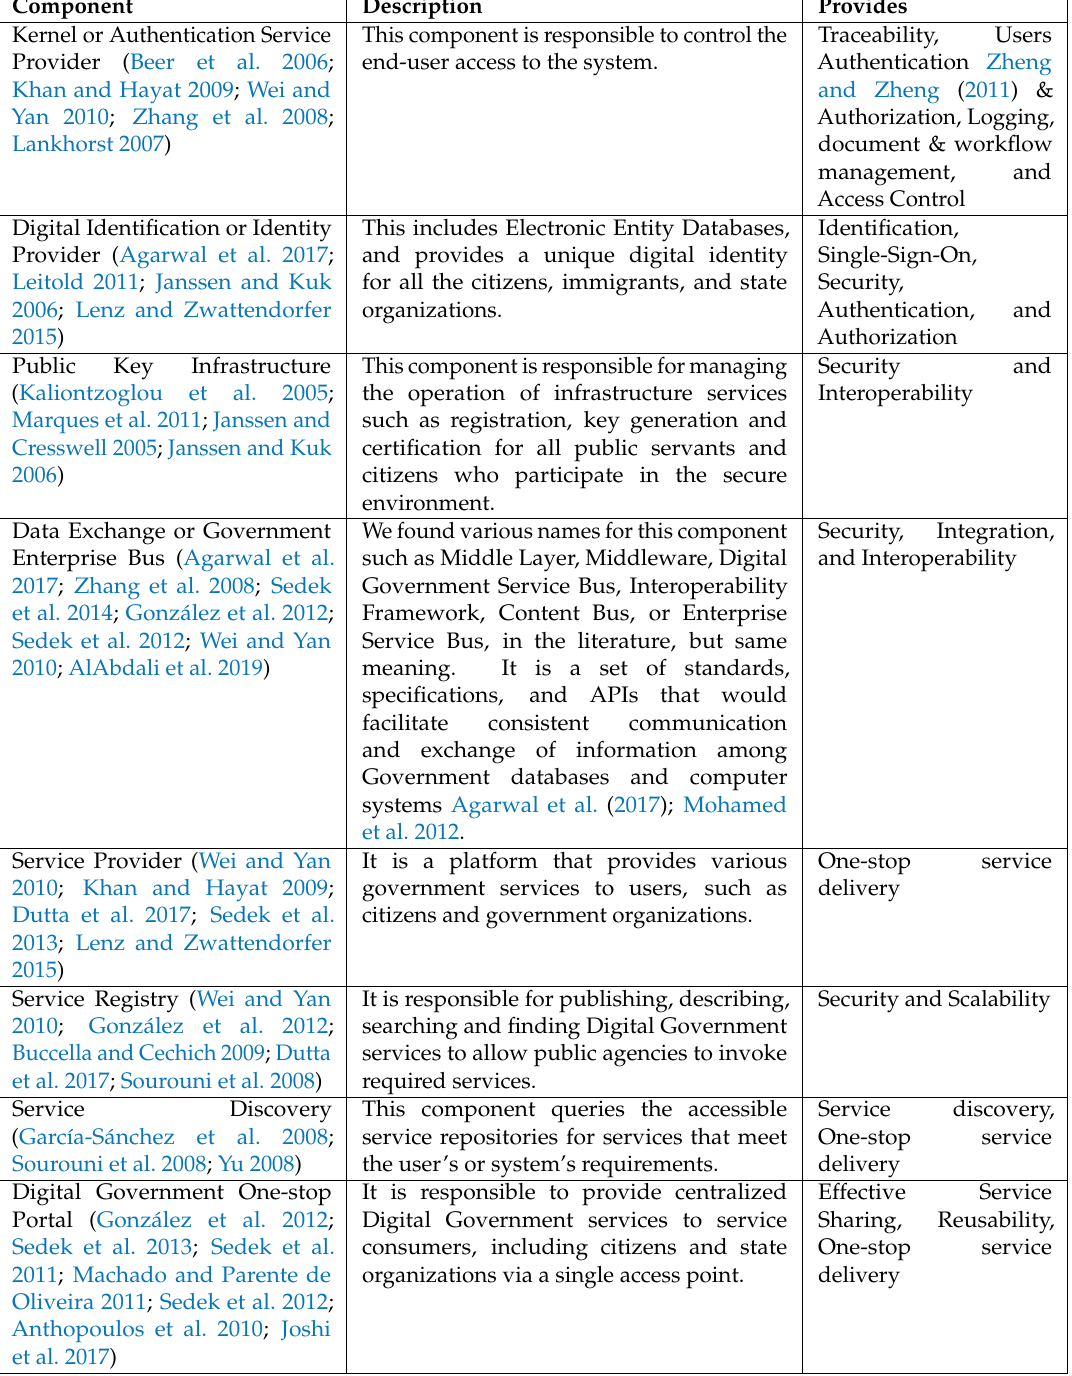
Table 4. Summary of basic architecture building blocks found in the existing